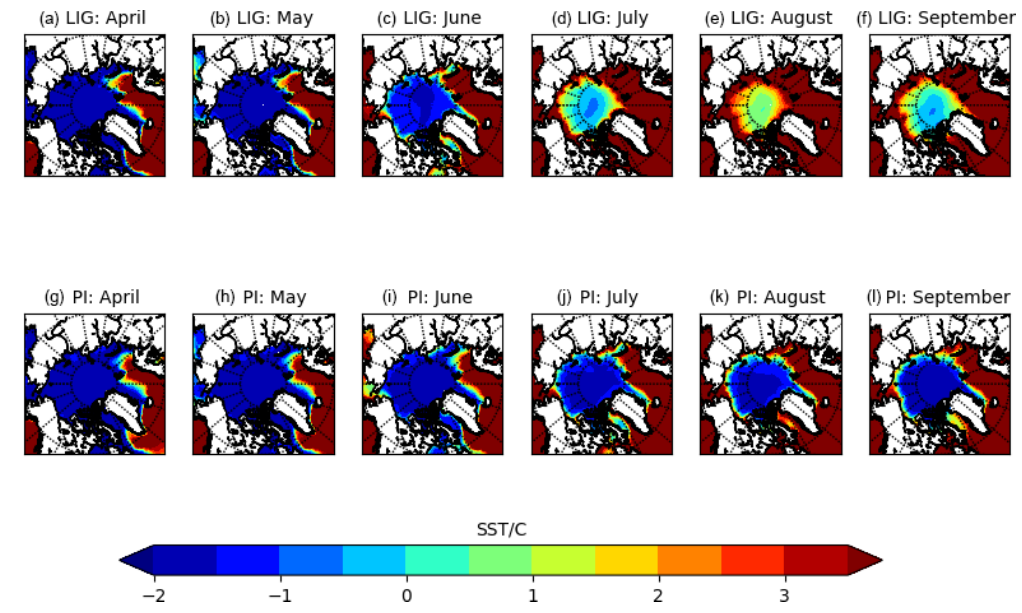
Figure 2. Mean sea surface temperature ( ◦ C) for the LIG and PI. The 200-year mean over the Northern Hemisphere for each month from April–September is shown, computed as the time average from monthly model output.